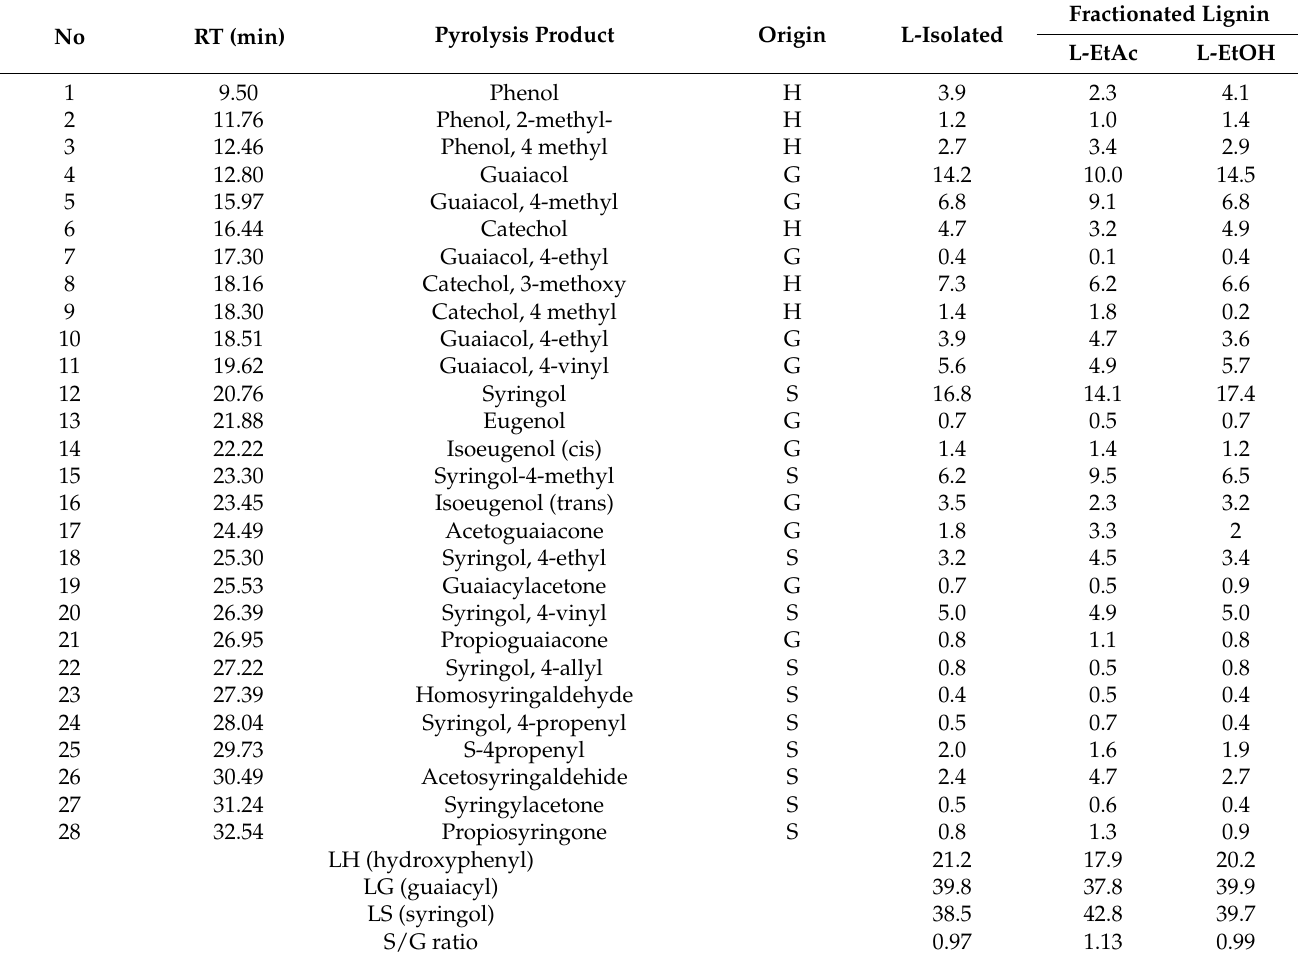
Table 4. Pyrolysis products of lignin assessed by